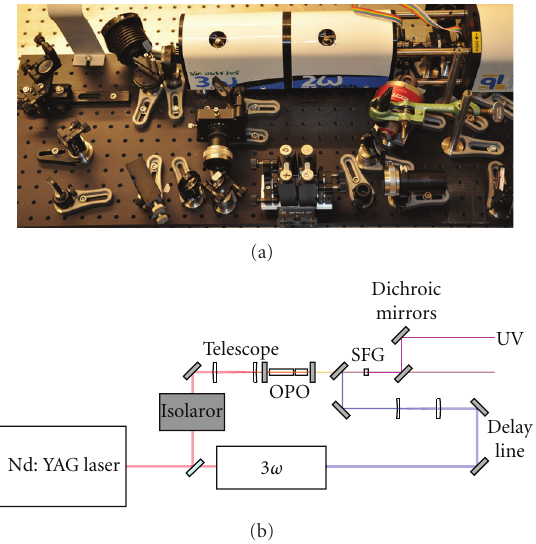
Figure 1: Top view of the experimental setup, depicted (a) and sketched (b). An adequate portion of the pulse energy was split o ff from the Nd:YAG-laser for OPO pumping. The residual energy generated 3 ω using the commercial harmonic generator modules. The OPO signal and 3 ω beams were combined in front of the SFG